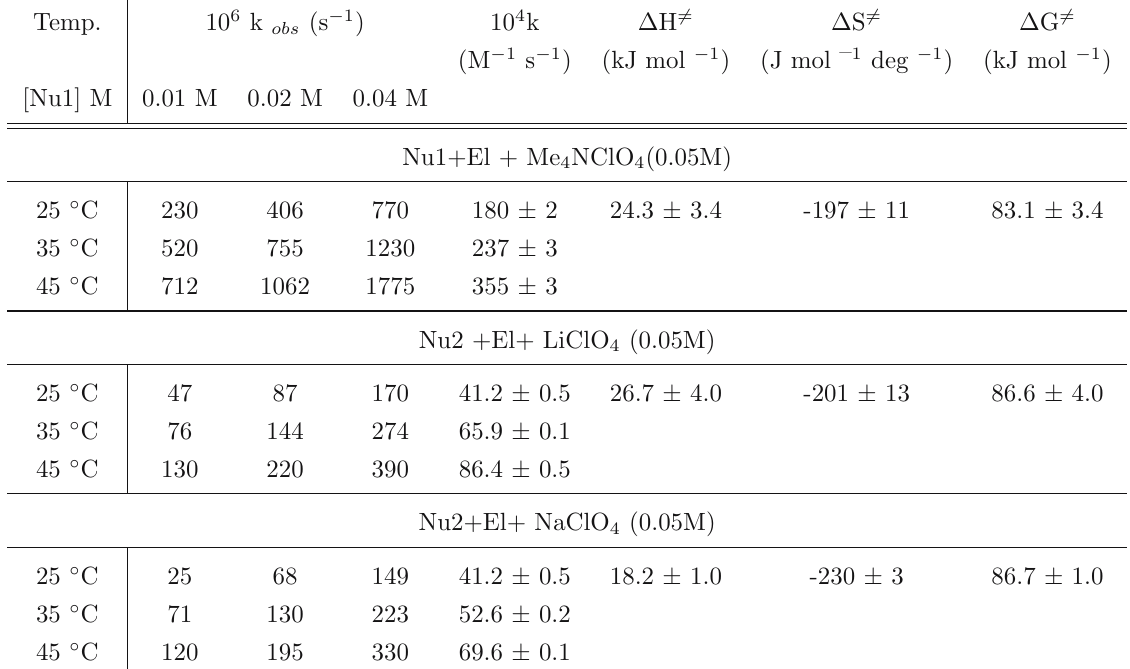
Table 5 Rate constants (k) and activation parameters ( ± standard deviation) of the reaction between Nu2 and El in acetonitrile.